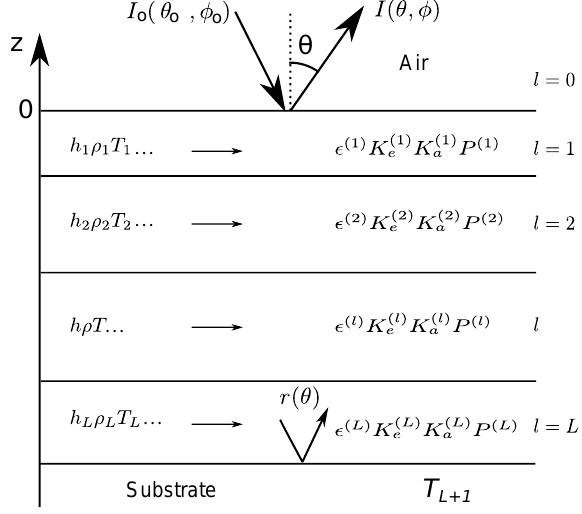
Figure 1. Multilayered medium modeled by SMRT. The incident radiation I o comes either from a radar beam (active mode) or from the sky (passive mode with atmospheric